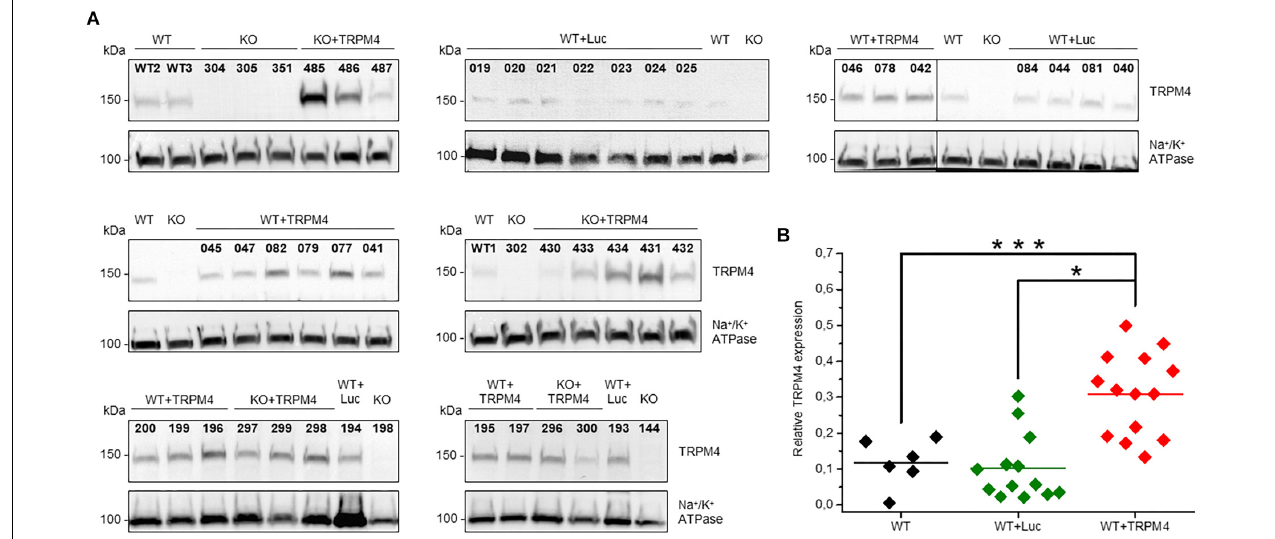
FIGURE 3 | Protein expression level of TRPM4 transduced by AAV9 from WT and TRPM4 − / − (KO) mouse hearts. (A) Each mouse whole heart was used for membrane fraction isolation, and 80 ug was loaded into SDS-PAGE gel. Immunoblots were revealed with anti-TRPM4 and anti Na + /K + ATPase α 1 antibodies. (B) Relative expression of TRPM4 compared to Na + /K + -ATPase (WT: n = 6, WT + Luc: n = 13, WT + TRPM4: n = 14; Kruskall-Wallis ANOVA followed by a Dunn’s post test, ∗ p < 0.05, ∗∗∗ p > 0.001).